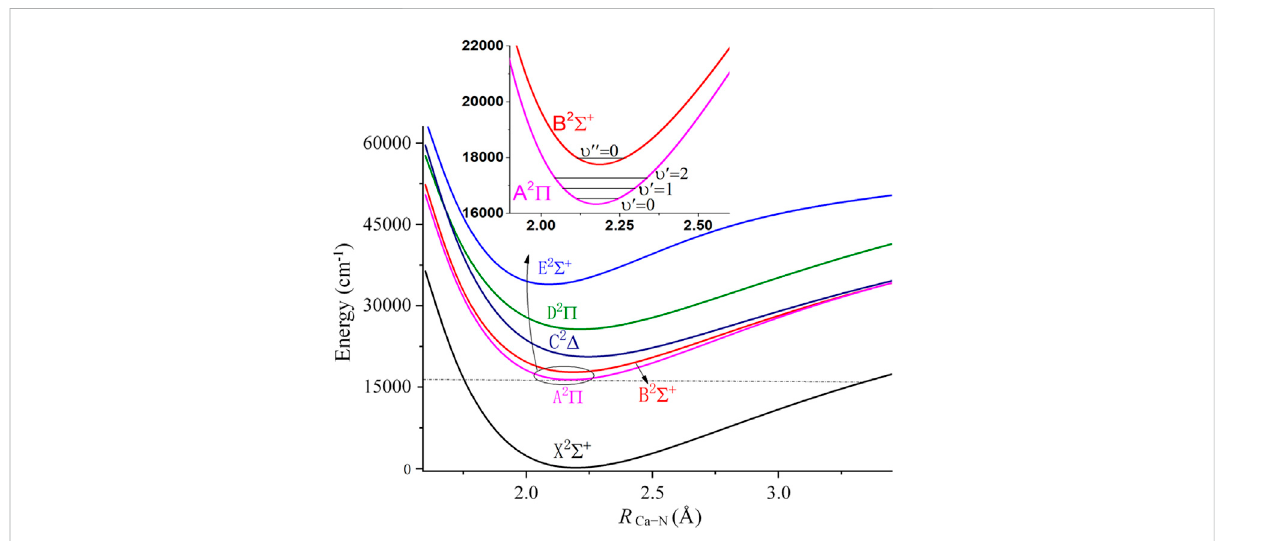
FIGURE 1 PotentialenergycurvesoflinearCaNCalongR Ca-N ,withR N-C fi xedat1.183Å.ThegraydashedlineshowsthattheminimumoftheAstateiswell below the dissociation limit of the X